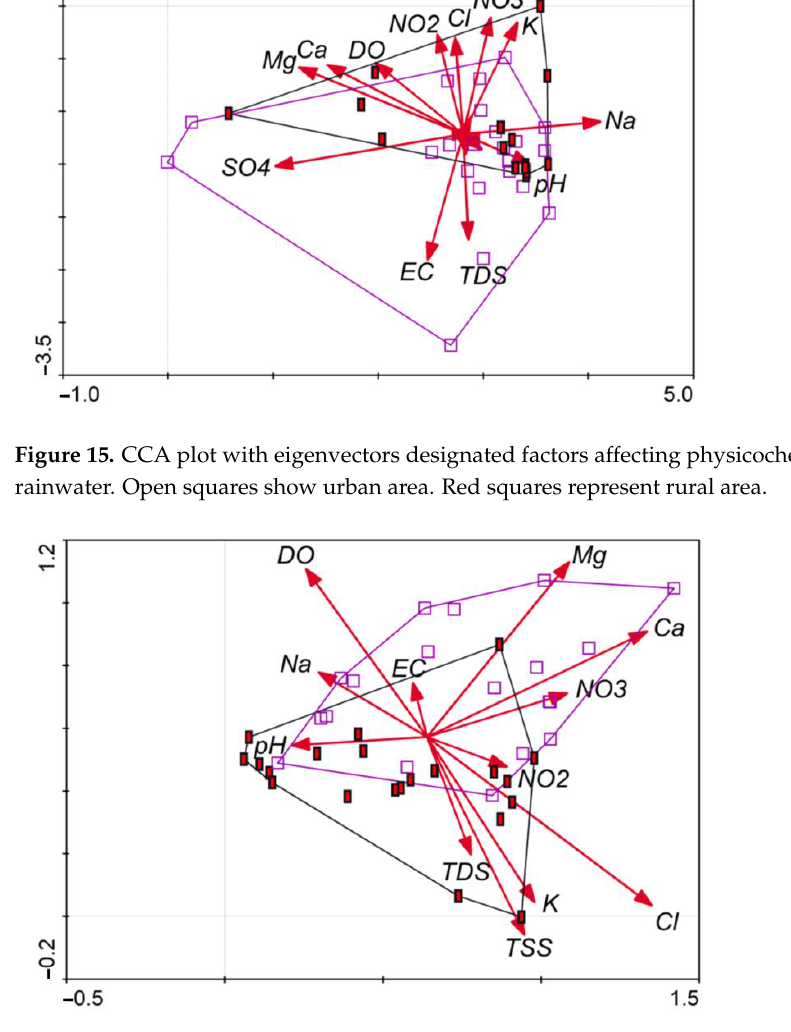
Figure 16. CCA plot with eigenvectors designated factors affecting physicochemical parameters in river. Open squares show urban area. Red squares represent suburban